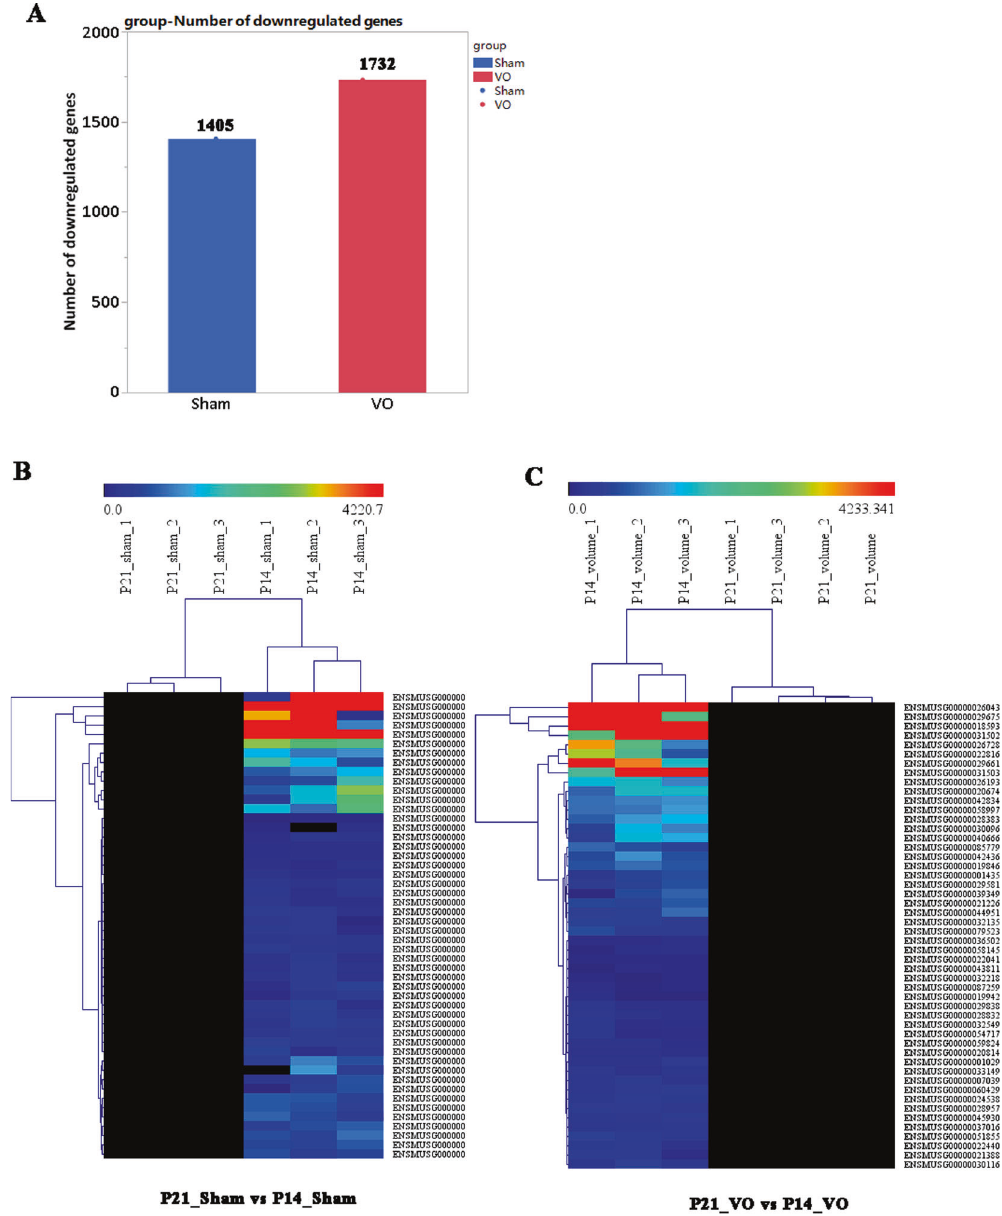
Fig. 3 The downregulated transcriptome of postnatal RV development is changed by VO. A The number of downregulated genes for postnatal RV development under normal conditions (P21_sham vs. P14_sham) and under the in fl uence of VO (P21_VO and P14_VO). B Cluster analysis of the downregulated genes in normal RV development (each group contained three mice). The redder the color, the higher the expression level; the bluer the color, the lower the expression level. The clusters of genes in each group are quite different from each other but similar within the same group. C Cluster analysis of the downregulated genes in VO-in fl uenced RV development (each group contained three mice). The redder the color, the higher the expression level; the bluer the color, the lower the expression level. The clusters of genes in each group are quite different from each other but similar within the same